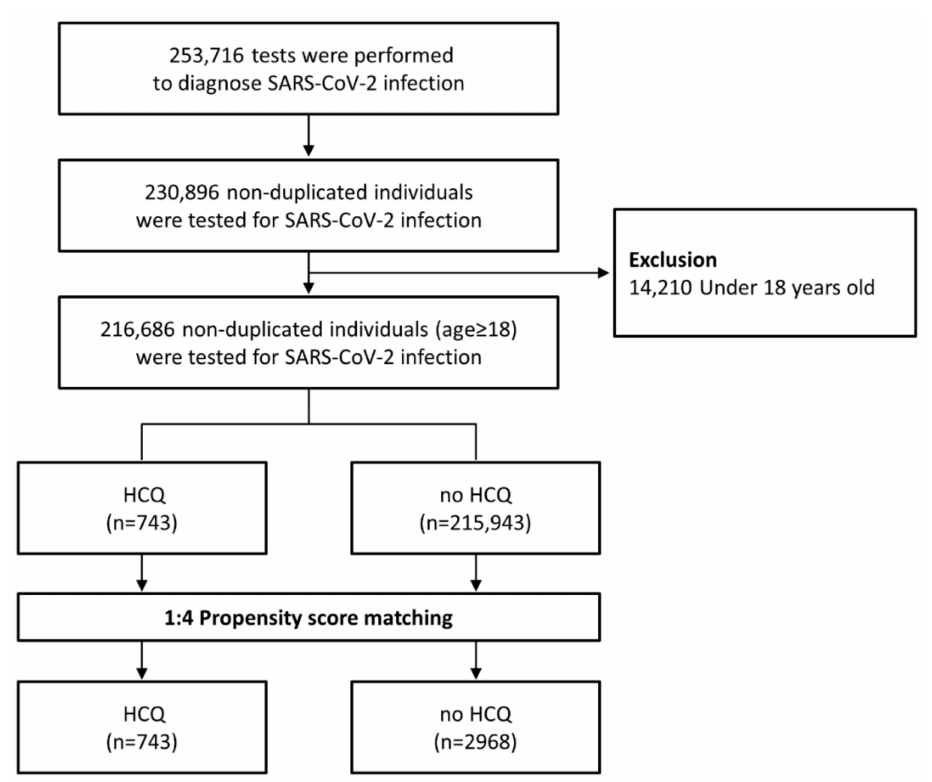
Figure 1. Flowchart of population selection and propensity-score-matched analysis. Table 1. Baseline characteristics of patients tested for